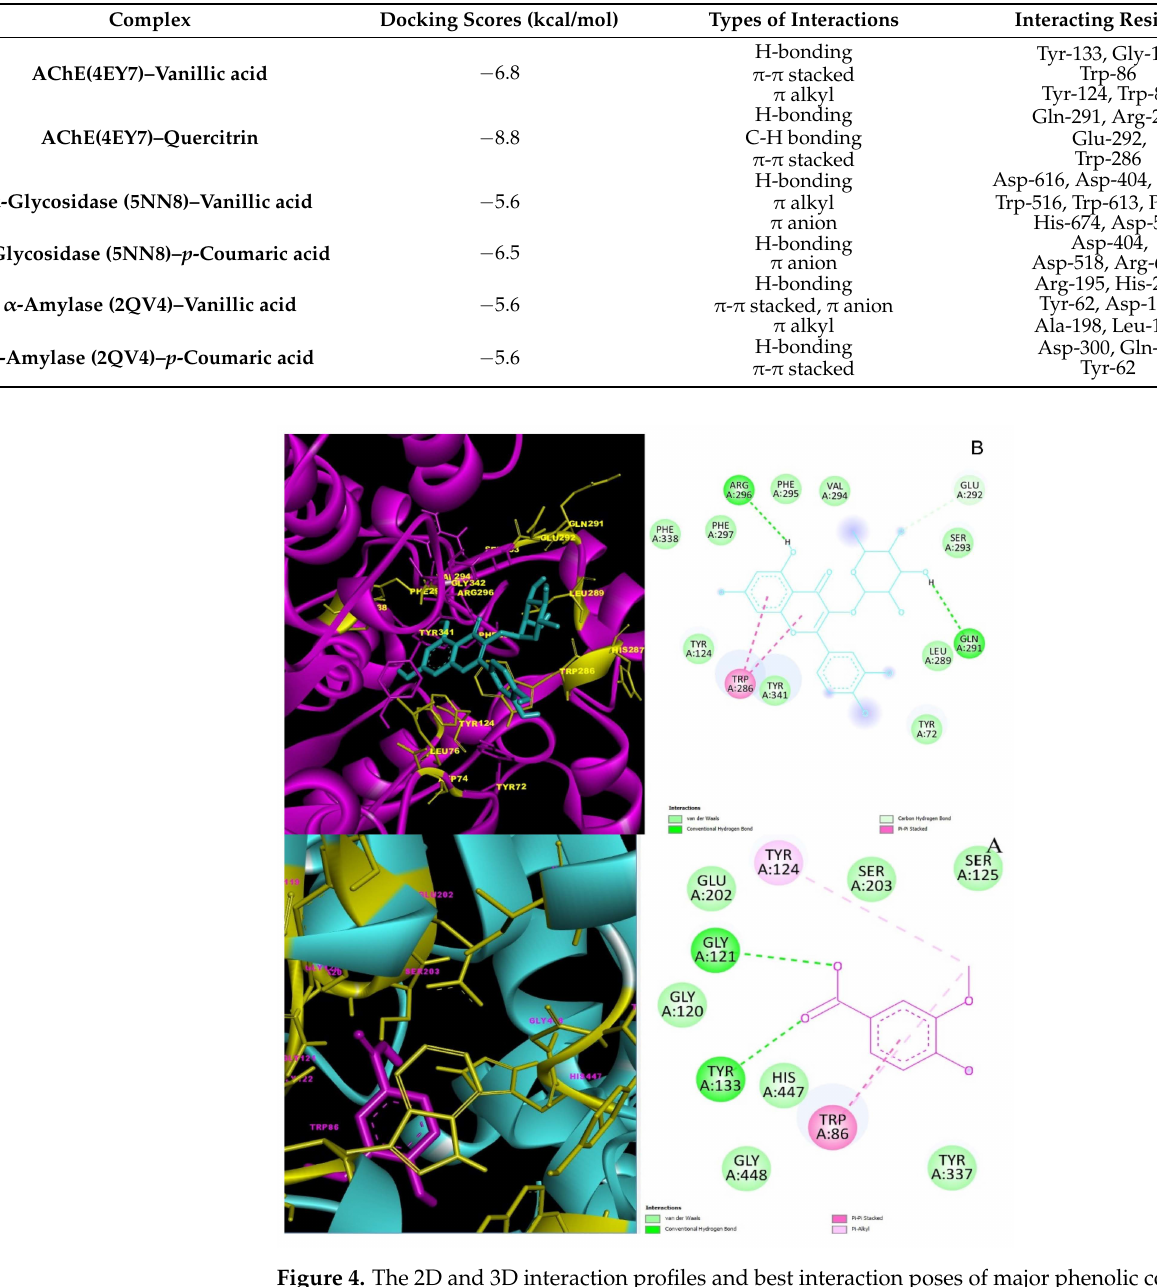
Figure 4. The 2D and 3D interaction profiles and best interaction poses of major phenolic compounds placed into the AChE (4EY7) by docking study: ( A ) Vanillic acid–AChE; ( B ) Quercitrin–AChE. p -Coumaric acid- α -glycosidase (5NN8) complex’s docking score was calculated to be -6.5 kcal/mol (Table 6). A conventional H-bond of p -coumaric acid with α -glycosidase Asp-404 residue and two π anion interactions with Asp-518 and Arg-600 residues are shown in Figure